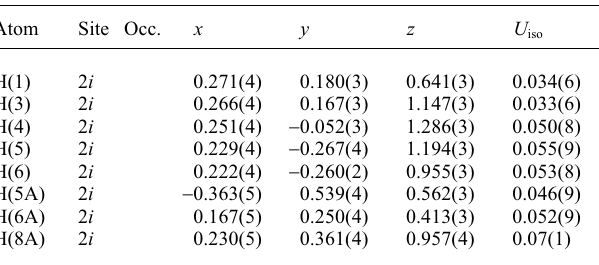
Table 2. Atomic coordinates and displacement parameters (in Å 2 )